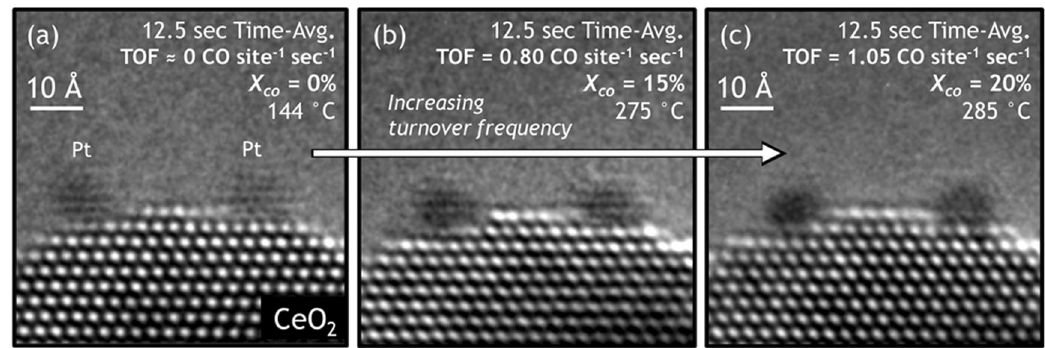
Fig. 4 Operando TEM images showing dynamic structural evolution of the Pt/CeO 2 catalyst at varying levels of activity for CO oxidation. a 12.5 s time- averaged image acquired at 144 °C, where the turnover frequency (TOF) was measured to be 0 CO site − 1 sec − 1 . b 12.5 s time-averaged image acquired at 275 °C, corresponding to a TOF of 0.80 CO site − 1 sec − 1 . c 12.5 s time-averaged image acquired at 285 °C, corresponding to a TOF of 1.05 CO site − 1 sec − 1 . The corresponding temperatures and CO conversions are stated in the respective fi gures.